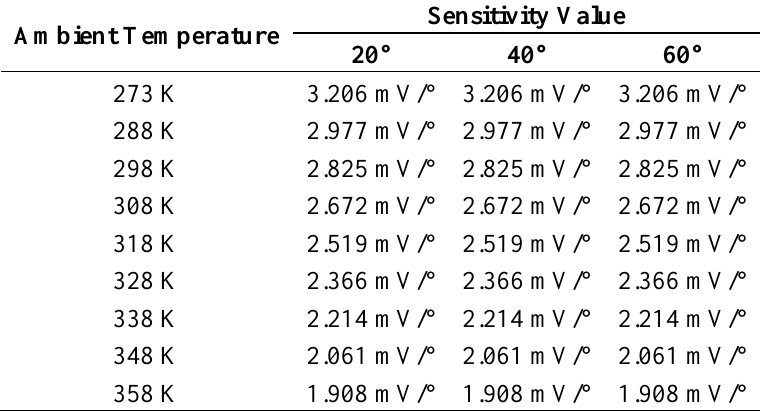
Table 1. Calculation of the sensitivity value for the sensor (the temperature of the heat source within the chamber is set as 483 K).